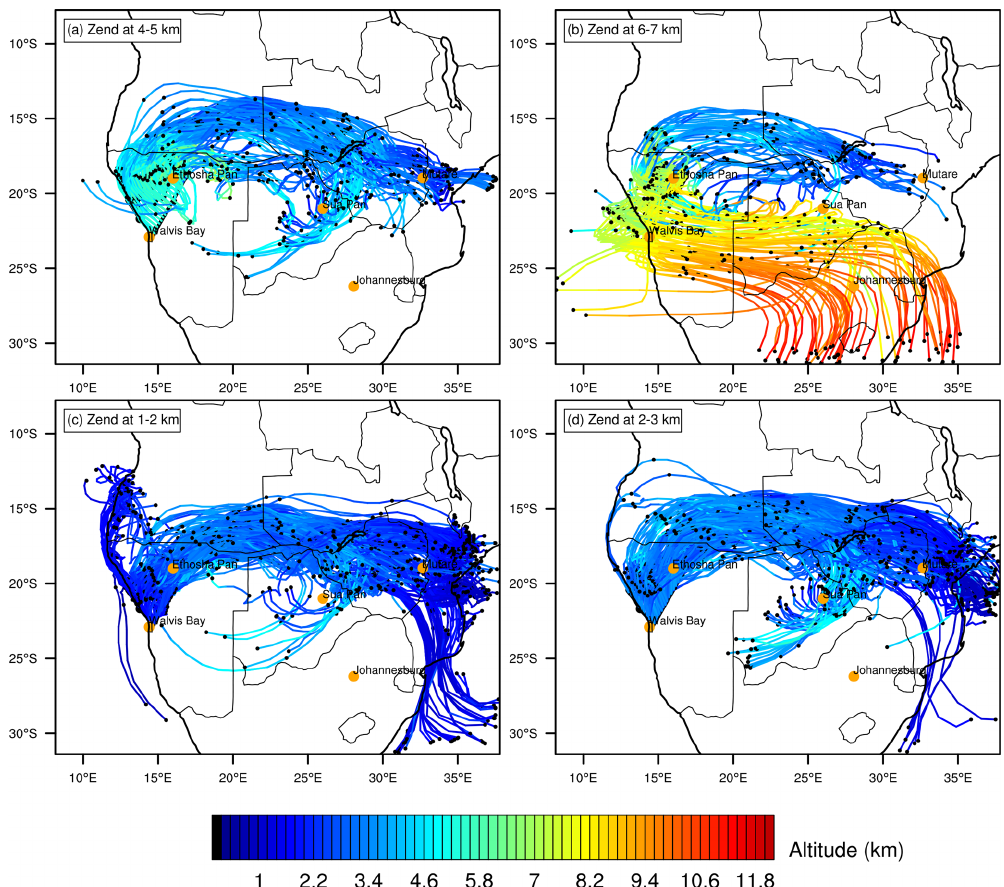
Figure 12. As in Fig. 10 but ending at 12:00UTC 6 September 2017 for the F09 flight track.